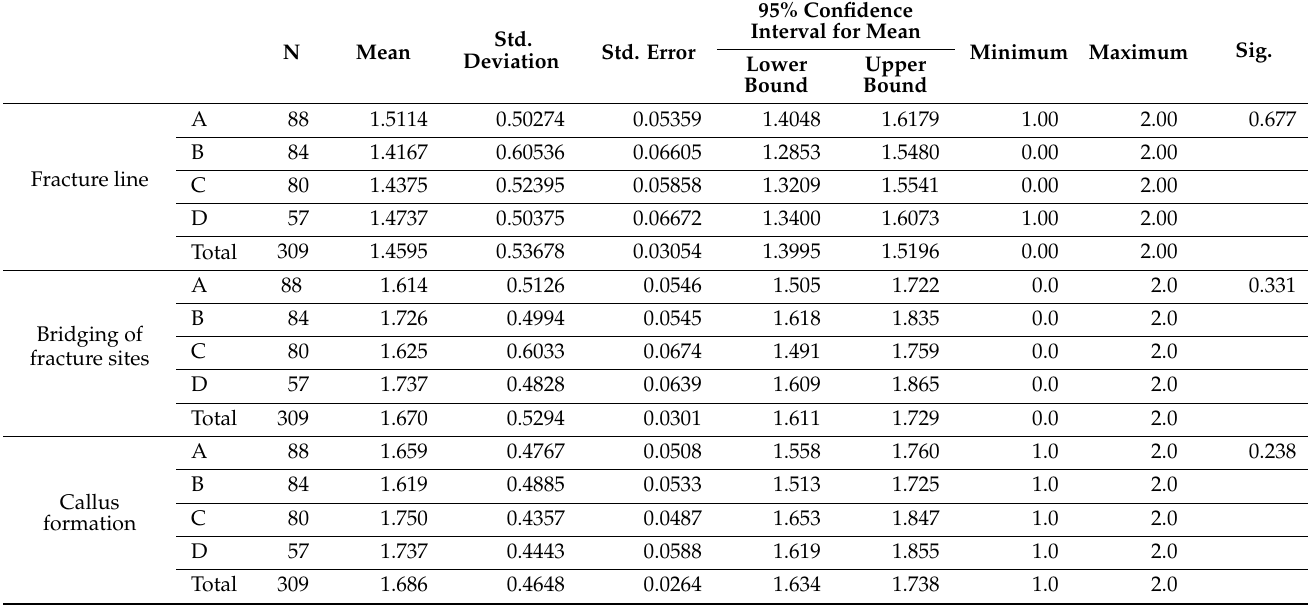
Table A1. Systematic point grading of all surgeons.